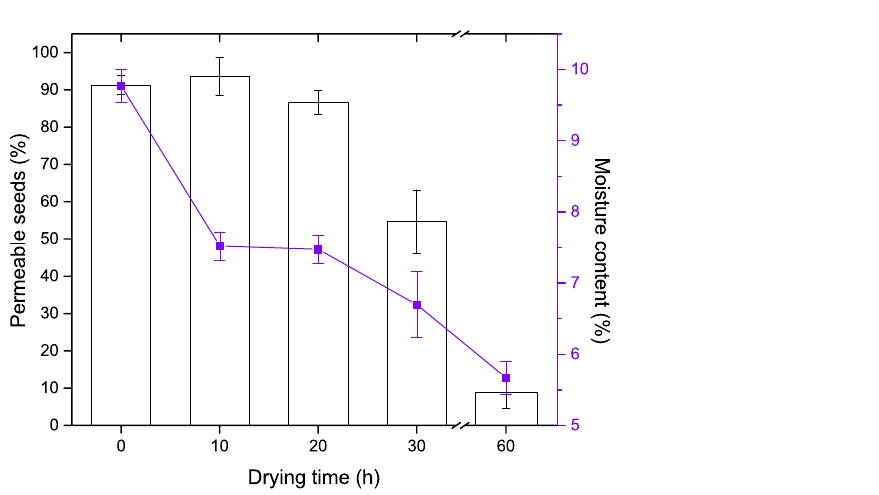
Figure 3. Relationship between moisture content and proportion of permeable seeds in Astragalus adsurgens